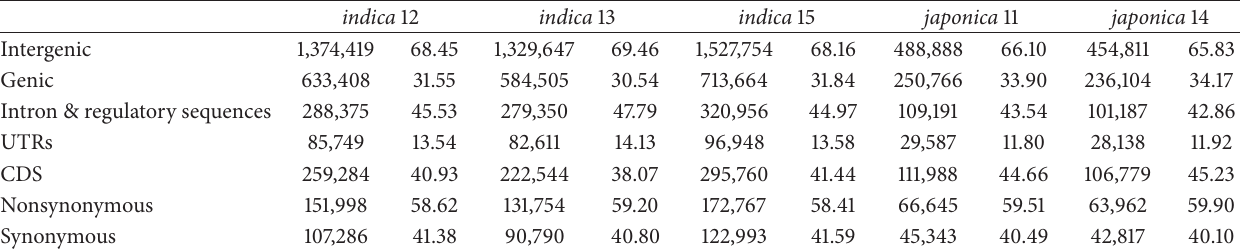
Table 3: Number of SNP effects annotated by SnpEff. SNPs were classified into various genomic regions (intergenic regions, intron, and exon) and effect terms by types. The total of intergenic, intronic, and exonic SNPs was more than the total number of SNPs due to overlapping gene models in the GFF